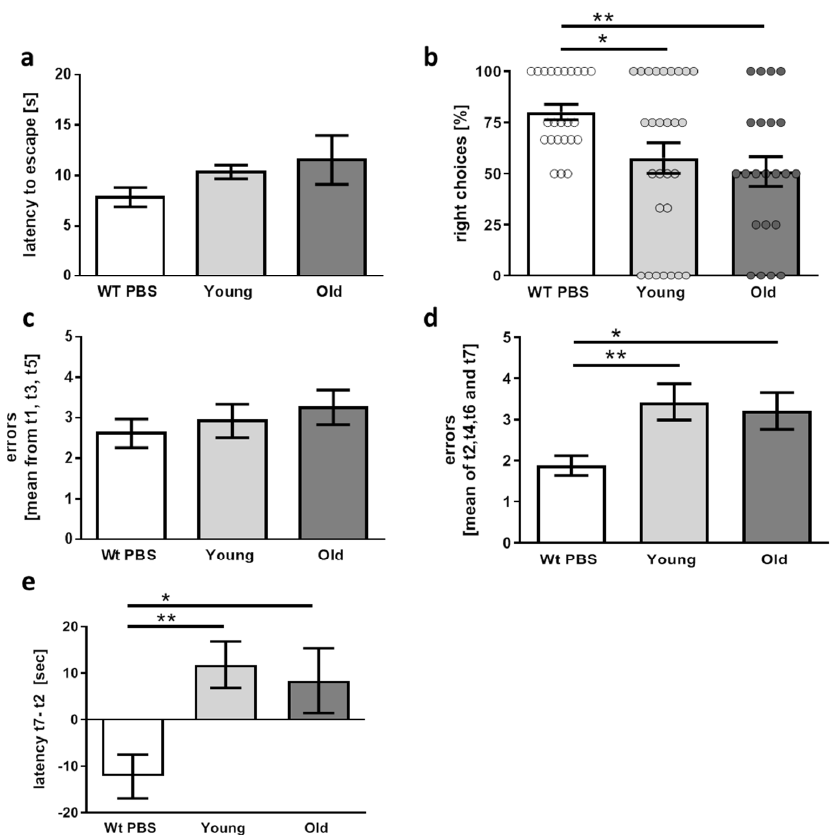
Figure 4. Performance of 5xFAD mice in behavioral tasks six weeks after FMT. ( a ) Latency to enter a brightly lit arena was measured as an anxiety-reporting parameter ( n = 13 for wild type and 11 for transgenic mice treated with cecal material from young or old donors (designated “young” and “old”)). ( b ) Percentage of right choices during two different testing days in the T-maze were assessed. Dots represent values measured from the individual days. ( c ) The radial arm water maze was applied with alternating visible and hidden platform up to trial 5, the last two trials were performed with hidden platform only. To exclude visual deficits, errors made with visible platform were counted within three trials (t1, t3, and t5). ( d ) Learning and short-term memory were tested within the trials with a hidden platform (t2, t4, t6, and t7). ( e ) Difference of latency for finding the hidden platform between trial 7 and trial 2 was calculated. ( b – e : n = 13 for wild type, n = 14 for transgenic mice treated with cecal material from young and 11 for mice treated with old donor material). Data are presented as mean ± SEM (*, p < 0.05; **, p < 0.01).